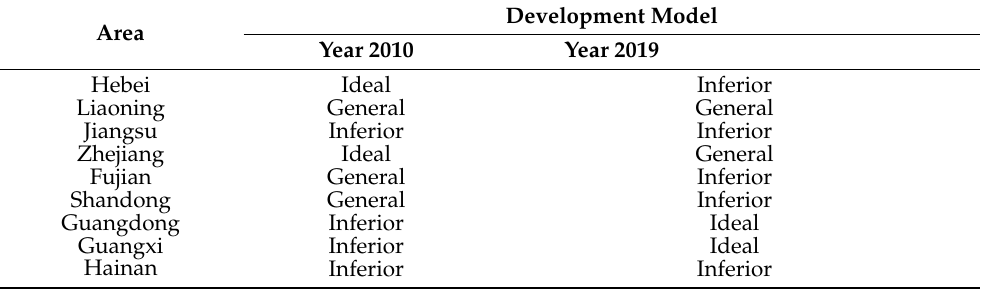
Table 18. Development mode of fishery economy in nine coastal provinces in 2010 and